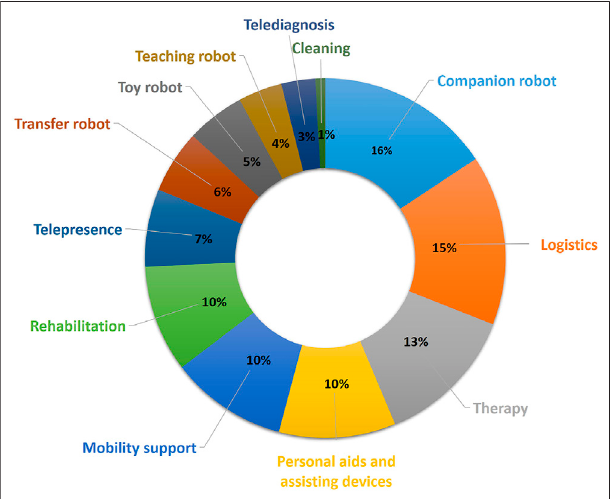
FIGURE 10 | Percentage of project per each category of the use case classi fi